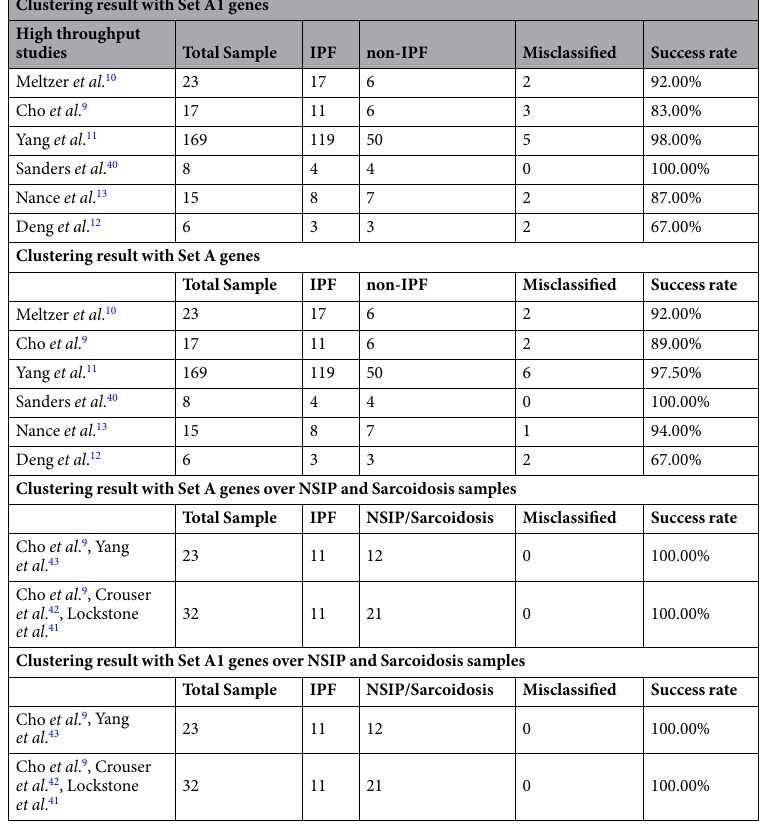
Table 1. K-means clustering of Set A1(82 DEGs) and A(39 DEGs) done to distinguish IPF from non IPF samples. For each IPF study, samples were clustered under IPF and Non IPF group. Results highlight better performance of Set A genes to classify both type of high throughput studies, contrary to Set A1. Both sets were able to correctly distinguish even the samples from IPF like diseases Sarcoidosis and NSIP from IPF with 100%